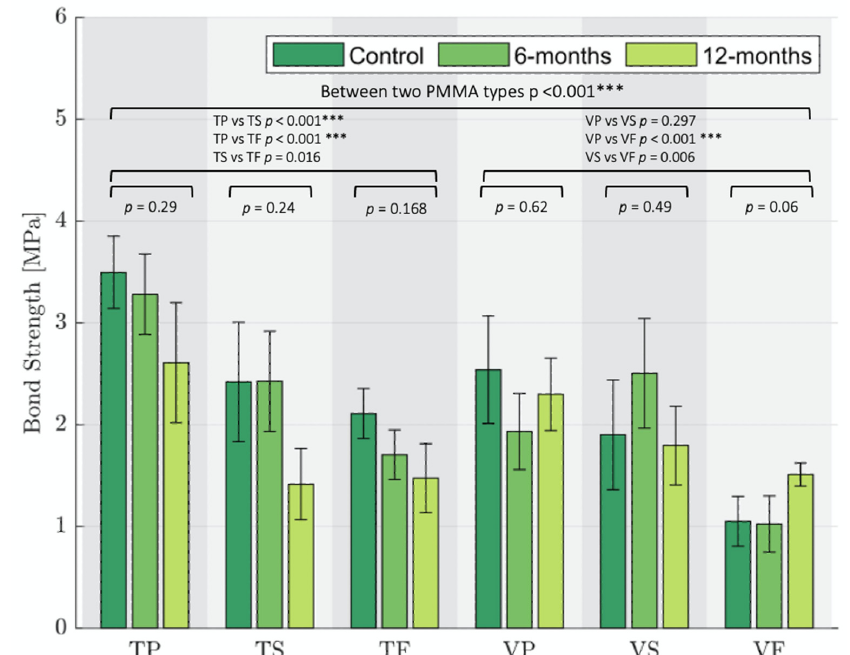
Figure 4. Flexural bond strength (MPa with mean bars) of all sample groups representing control, 6 months and 12 months. The vertical lines represent 95% Confidence Interval ranges for Tukey’s pairwise comparisons. *** indicates a statistical significance level p < 0.001